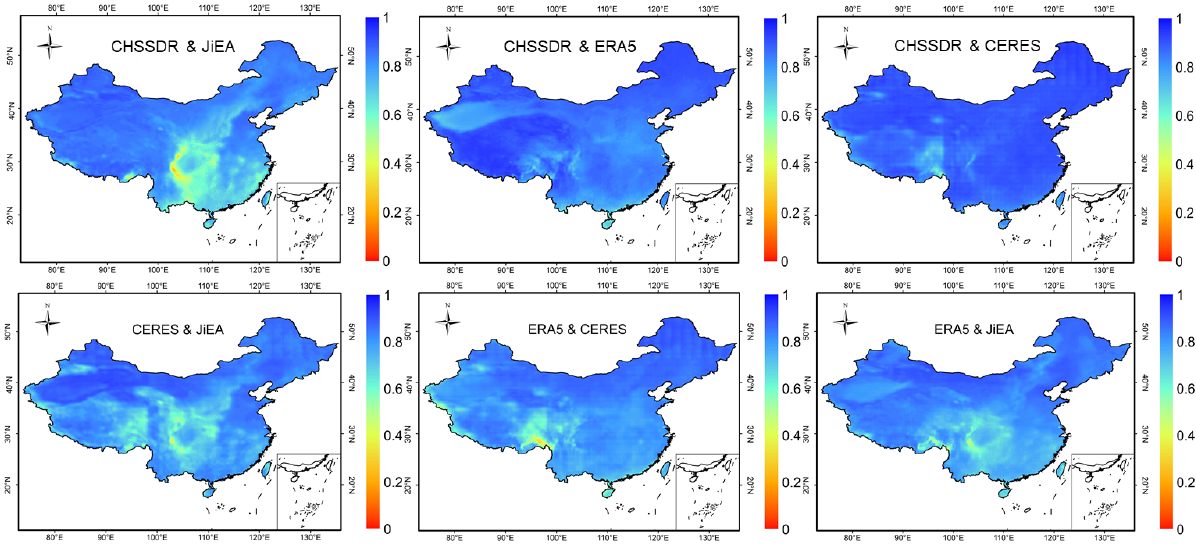
Figure 7. Spatial distribution of cross-validated correlations of surface diffuse solar radiation prod- ucts.